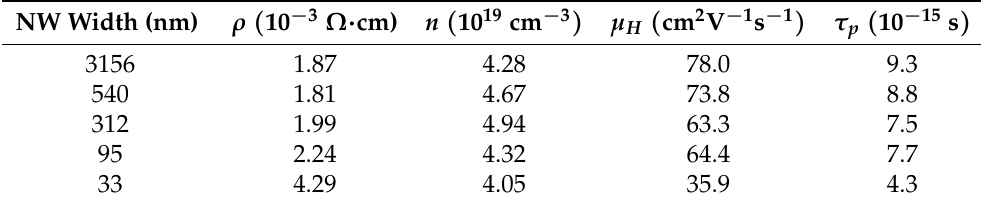
Figure 4. ( a ) Current–voltage curve via two-probe measurement; ( b ) voltage–current curve via four- probe measurement of GeNW with an average width of 33 nm. ( c ) Two- and four-probe resistance and ( d ) normalized GeNW resistivity as a function of NW width. Table 1. Resistivity ( ρ ), carrier concentration ( n ), carrier mobility ( µ H ), and average relaxation time of carriers ( τ p ) at room